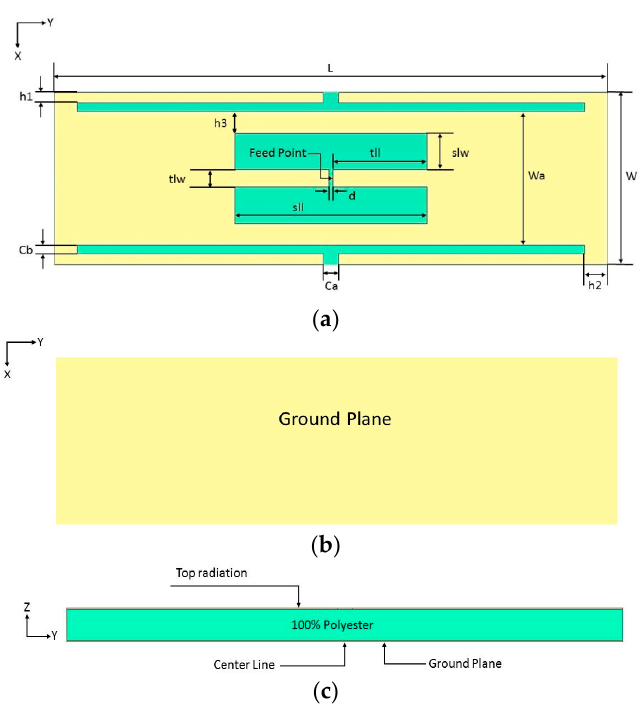
Figure 1. Proposed slotted tag antenna. ( a ) Top view, ( b ) ground plane, and ( c ) side view.